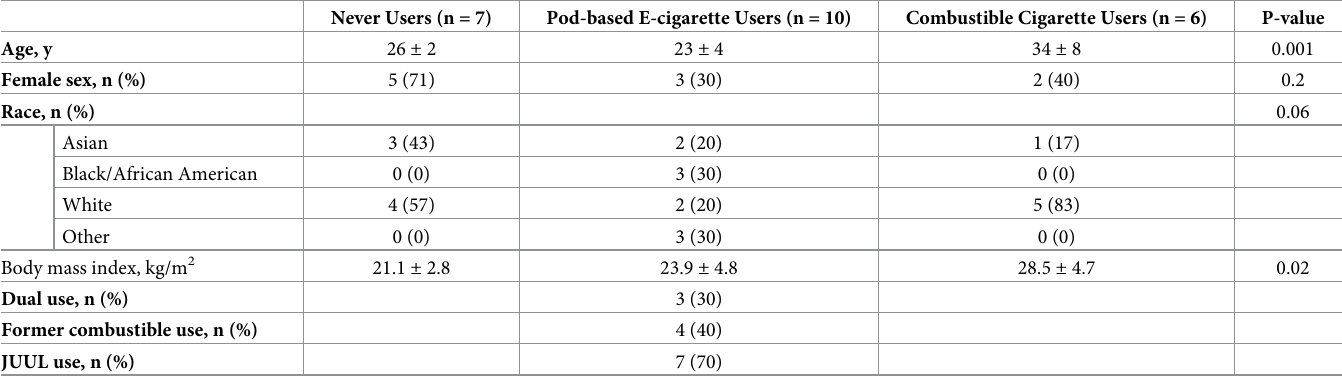
Table 1. Clinical